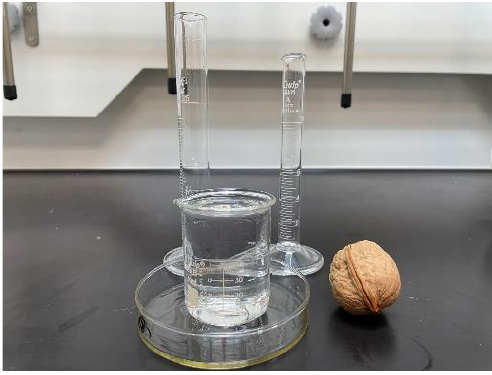
Figure 8. Set up for the nut with the WDM.